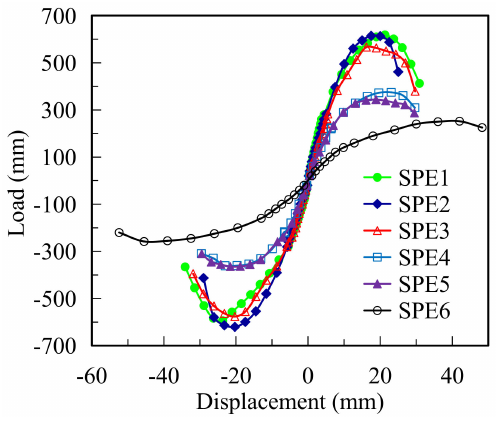
Figure 12. Skeleton